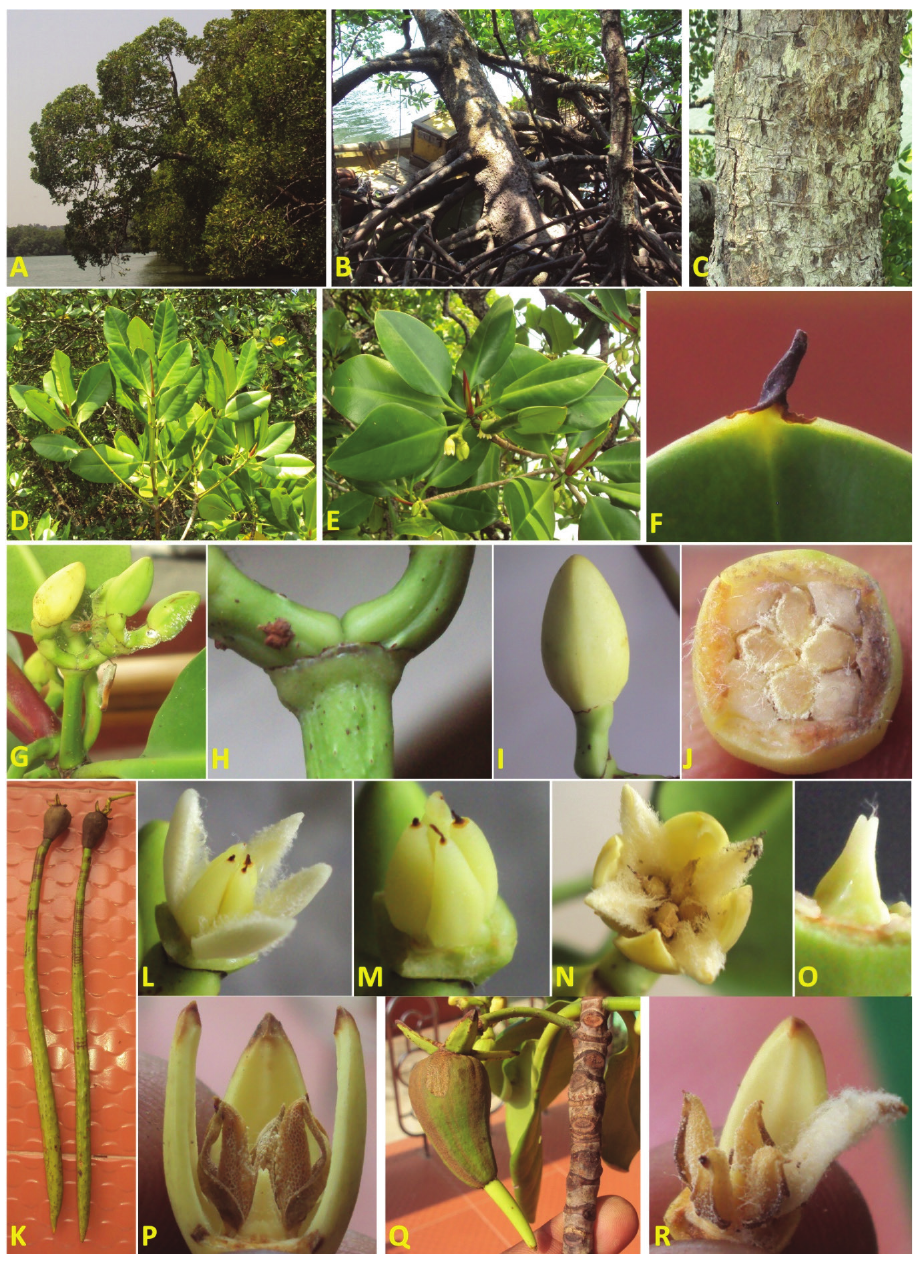
Figure 2. Rhizophora mucronata var. alokii ( A ) habit ( B ) stem base with stilt roots ( C ) bark ( D ) branches ( E ) leafy branch end with flowers ( F ) leaf apex with mucro ( G ) inflorescence ( H ) minute bract at dichotomous inflorescence branch ( I ) mature bud with minute bracteole below calyx ( J ) cross section of bud ( K ) mature propagules ( L ) thick leathery petal ( M ) stamens ( N ) flower ( O ) pistil showing four-sided ovary ( P ) flower with one petal removed ( Q ) pear-shaped fruit ( R ) stamens with